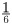
Simulation of the financial market model with semi-infinite state-space and inhomogeneous firing thresholds.The results from ten independent simulations each of 150,000 cascades is presented where firing thresholds are distributed among the agent population according to a geometric distribution, given by Eq (20), with parameter 16. This distribution is right-skewed meaning there are many more agents with low K firing thresholds than agents with high K thresholds. In contrast to when the distribution of firing thresholds is left-skewed, as in Eq (19), hyperbolic decay is not exhibited. (a) A sample from one of the ten simulated log-returns series. (b) Comparison of the distribution of log-returns arising from the model (△) with a moment matched Gaussian distribution (•), shown in log-log scale clearly showing fat-tails. All simulated data used. (c) one standard deviation envelope around the mean volatility autocorrelation of log-returns (r and black) and absolute log-returns (|r| and red) with lag L, together with the non-linear least squares fit of exponential (labelled E—solid line), logarithmic (labelled G—dashed line) and hyperbolic (labelled P—dotted line) decay functions, with exponential decay providing the best fit. All simulated data used. (d) a random sample of three out of ten volatility autocorrelation computations with hyperbolic decay lines of best fit, shown in log-log scale.